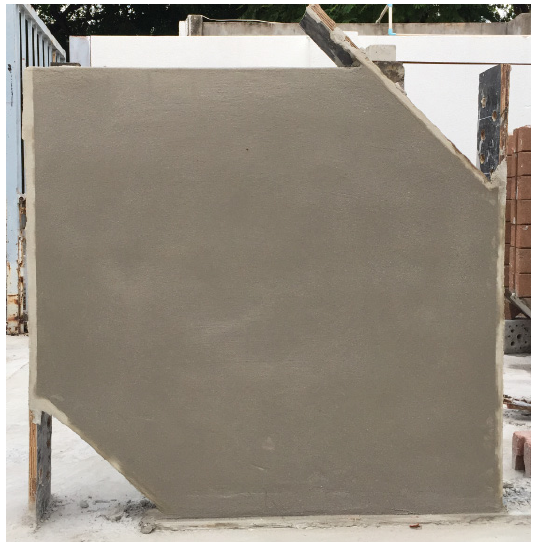
Figure 9. The attachment of wire mesh to the CCIH bricks.